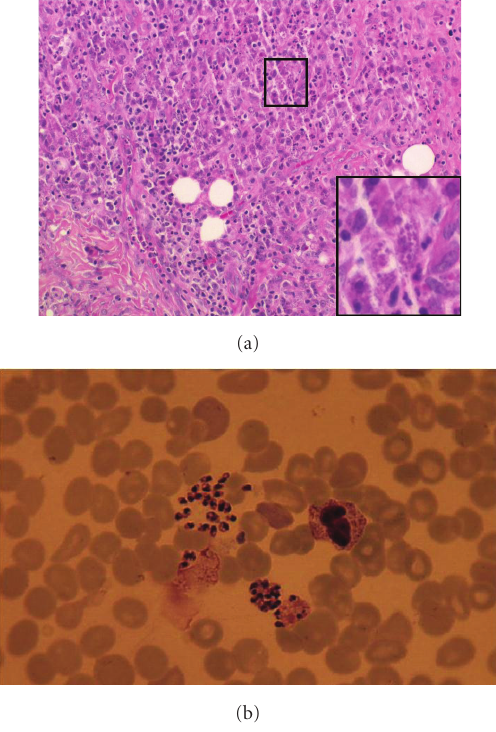
Figure 2: (a) Skin biopsy demonstrating a dense infiltrate of his- tiocytic cells with Donovan bodies. (b) Donovan bodies in bone marrow